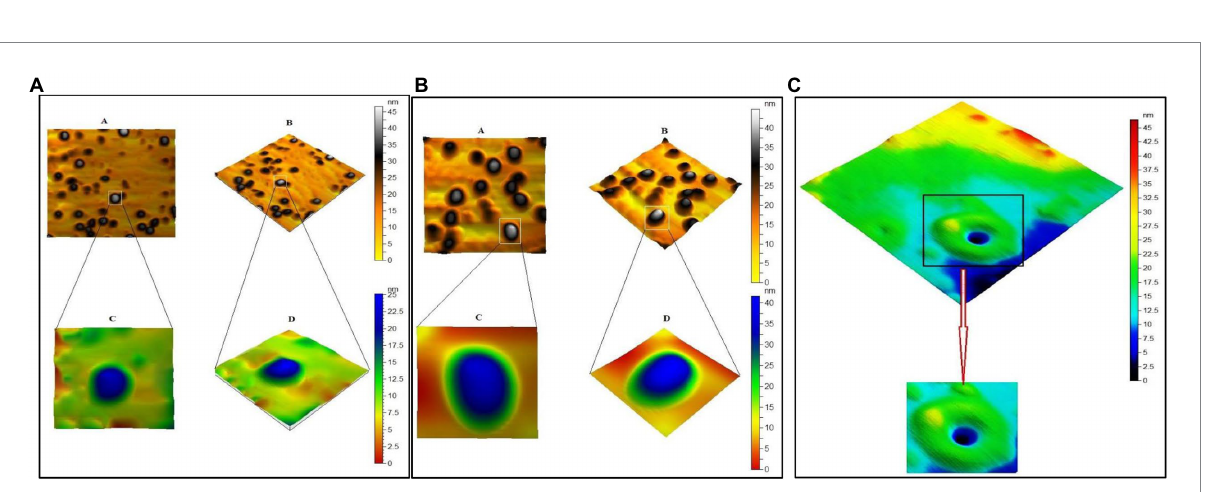
TABLE 1 The diameter of zone inhibition (mm), MIC value (mg/ml), and MBC value ( μ g/ml) for Escherichia coli.